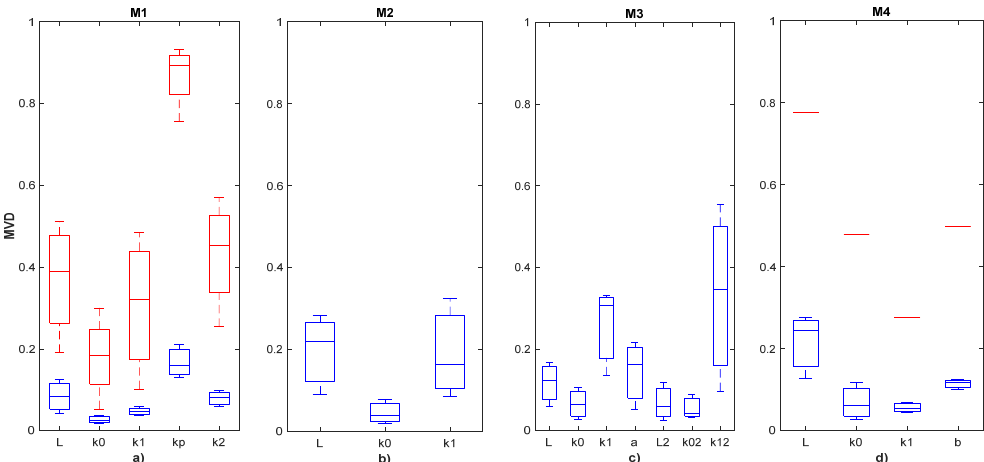
Figure 4. MVD variation in watersheds with (i) volcanic influence in red boxplots (CHE, DSL, CR, ALL); (ii) sedimentary influence in blue boxplots (CHC, DL, QL, CA). With models M2 and M3, no behavioral models were obtained in volcanic watersheds; therefore, no sensitivity analysis was carried out.